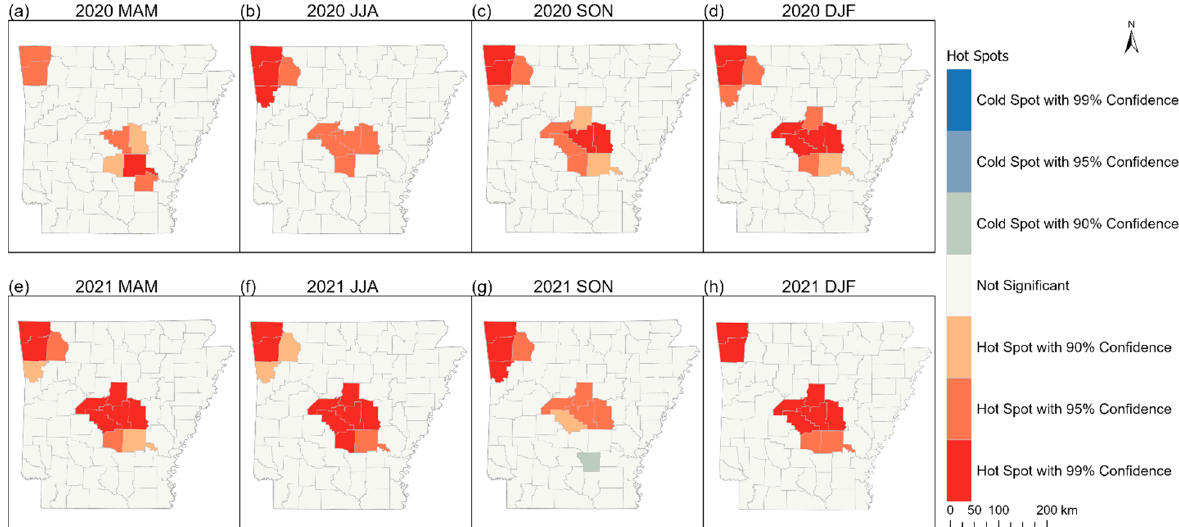
Figure 3. Hot spot analysis for the cumulative COVID-19 cases for each season from 2020 to 2021.